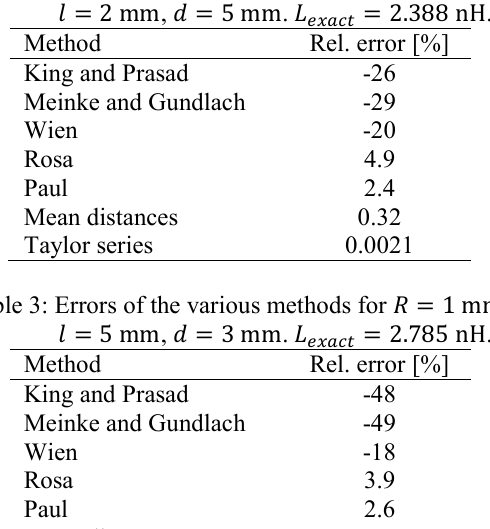
Table 2: Errors of the various methods for